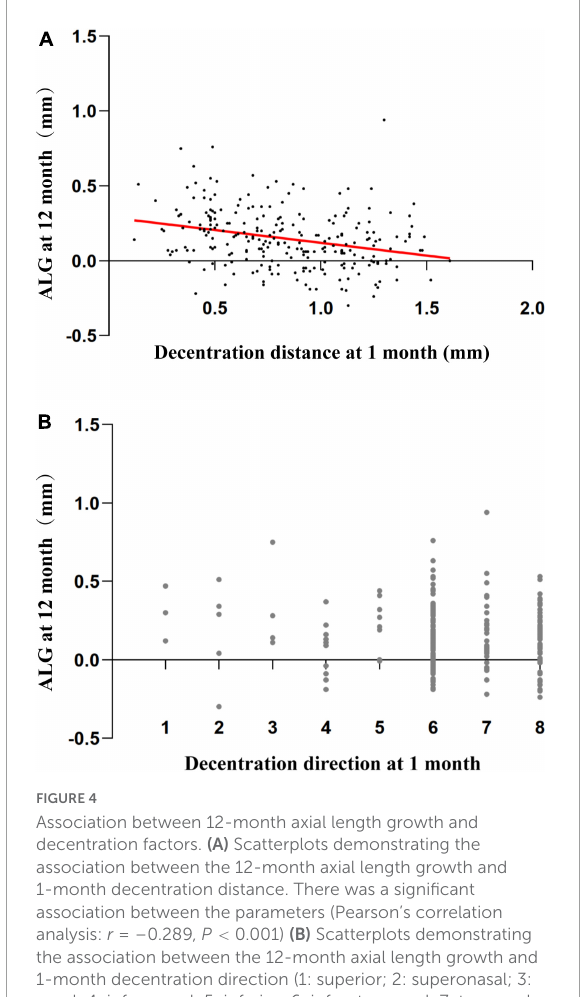
FIGURE4 Association between 12-month axial length growth and decentration factors. (A) Scatterplots demonstrating the association between the 12-month axial length growth and 1-month decentration distance. There was a significant association between the parameters (Pearson’s correlation analysis: r = –0.289, P < 0.001) (B) Scatterplots demonstrating the association between the 12-month axial length growth and 1-month decentration direction (1: superior; 2: superonasal; 3: nasal; 4: inferonasal; 5: inferior; 6: inferotemporal; 7: temporal; 8: superotemporal). There was no association between 12-month axial length growth and 1-month decentration direction (Spearman’s correlation analysis: r = –0.028, P =